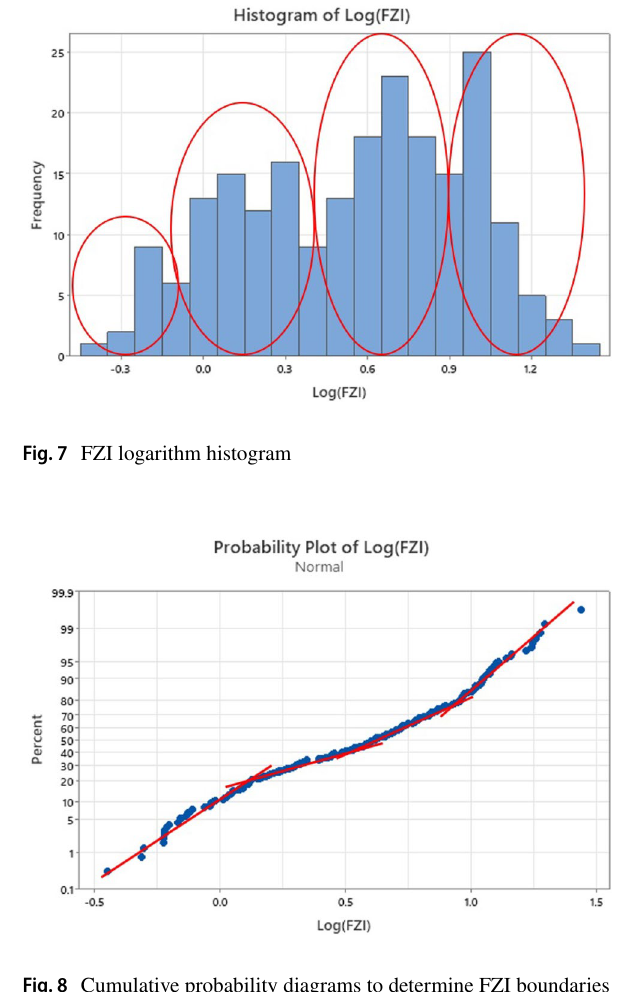
Fig. 8 Cumulative probability diagrams to determine FZI boundaries